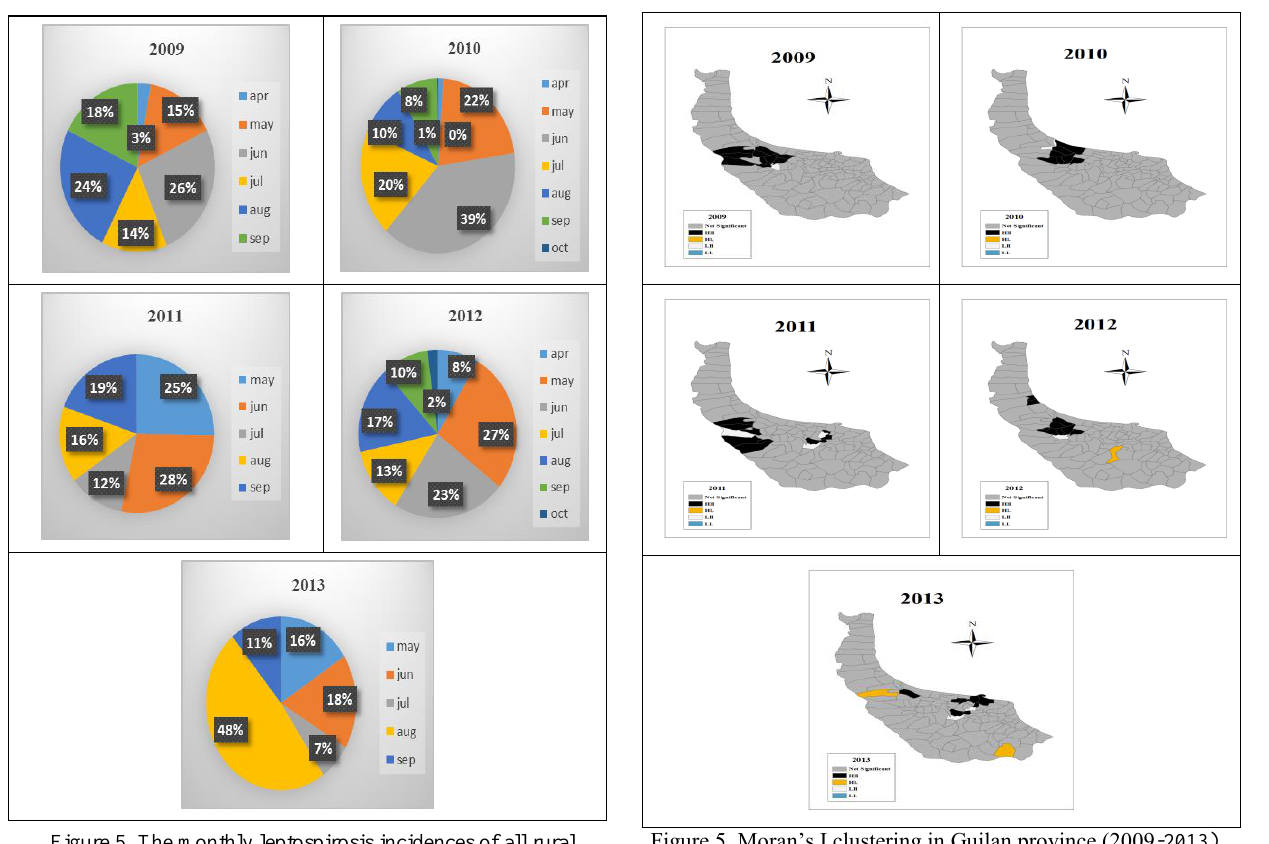
Figure 5. The monthly leptospirosis incidences of all rural districts in Guilan province for 2009-2013. west of Guilan province (Figure 6).